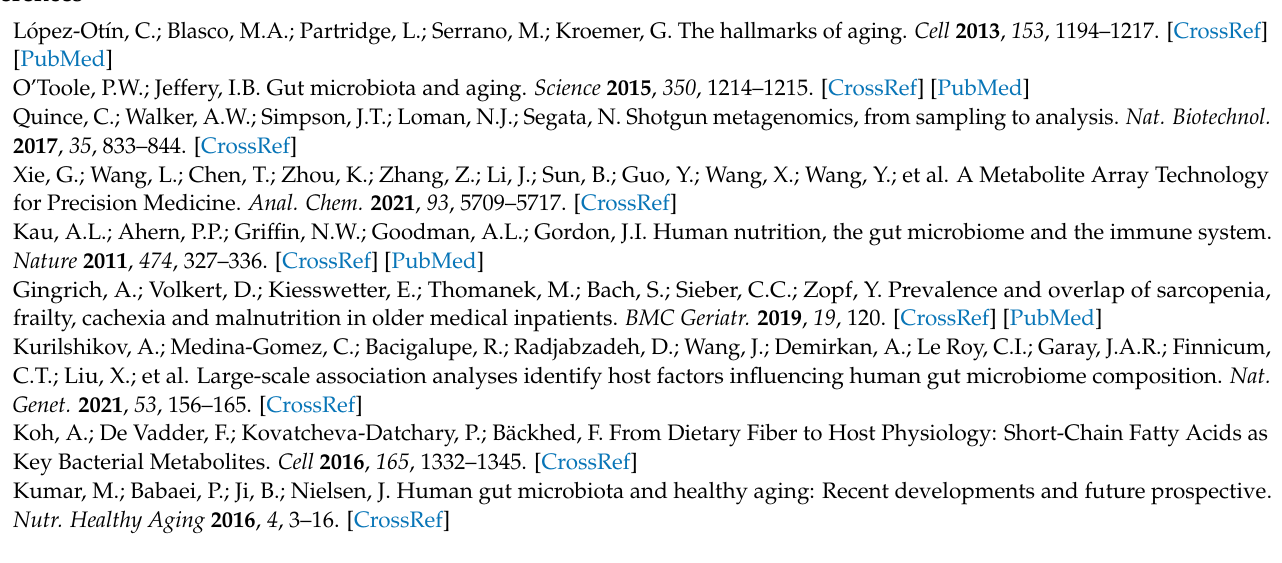
for base line studies along seasonal change; Figure S3: Box-plot of abundant beneficial intestinal bacteria; Figure S4: The differential KOs enriched in T0 and C0 groups. Figure S5: Correlation analysis between the differential species and the differential KOs by spearman correlation coefficient. Figure S6: Correlation analysis between the differential KOs and the metabolites by spearman correlation coefficient. Figure S7: Box-plot of five clinical biomarkers indicative of gut integrity. Figure S8: The Principal Co-ordinates Analysis (PCoA) plot showed the comparison of the microbiota structure between subjects of this study and the latest available metagenome databases from 7 cohorts. Figure S9: The association analysis between metabolites and clinical phenotypes using MaAsLin (FDR < 0.1). Table S1. The basic information of subjects in this study; Table S2. The clinical data of all the samples in this study; Table S3.The statistics of the sequencing reads of all the samples in this study; Table S4a. The differential genus between T3 group and T0 group (Wilcoxon rank-sum test p < 0.05 and at least one group’s median abundance more than 2e-8); Table S5a. The differential species between T3 group and T0 group which were accompanied with the change of probiotic Clostridium butyricum ; Table S6a. The differential metabolites between T3 group and T0 group; Table S7a. The differential KOs between T3 group and T0 group; Table S8a. The statistics of the pathways of the differential KOs in T3 group; Table S9a. The differential analysis of the clinical factors between T3 group and T0 group. Author Contributions: Conceptualization and funding acquisition, H.Q. and L.L. (Lin Liu); method- ology and resources, H.Q. and L.L. (Lu Liu); software and formal analysis, X.C.; validation, investiga- tion, data curation, writing-original draft preparation, L.L. (Lin Liu); writing—review and